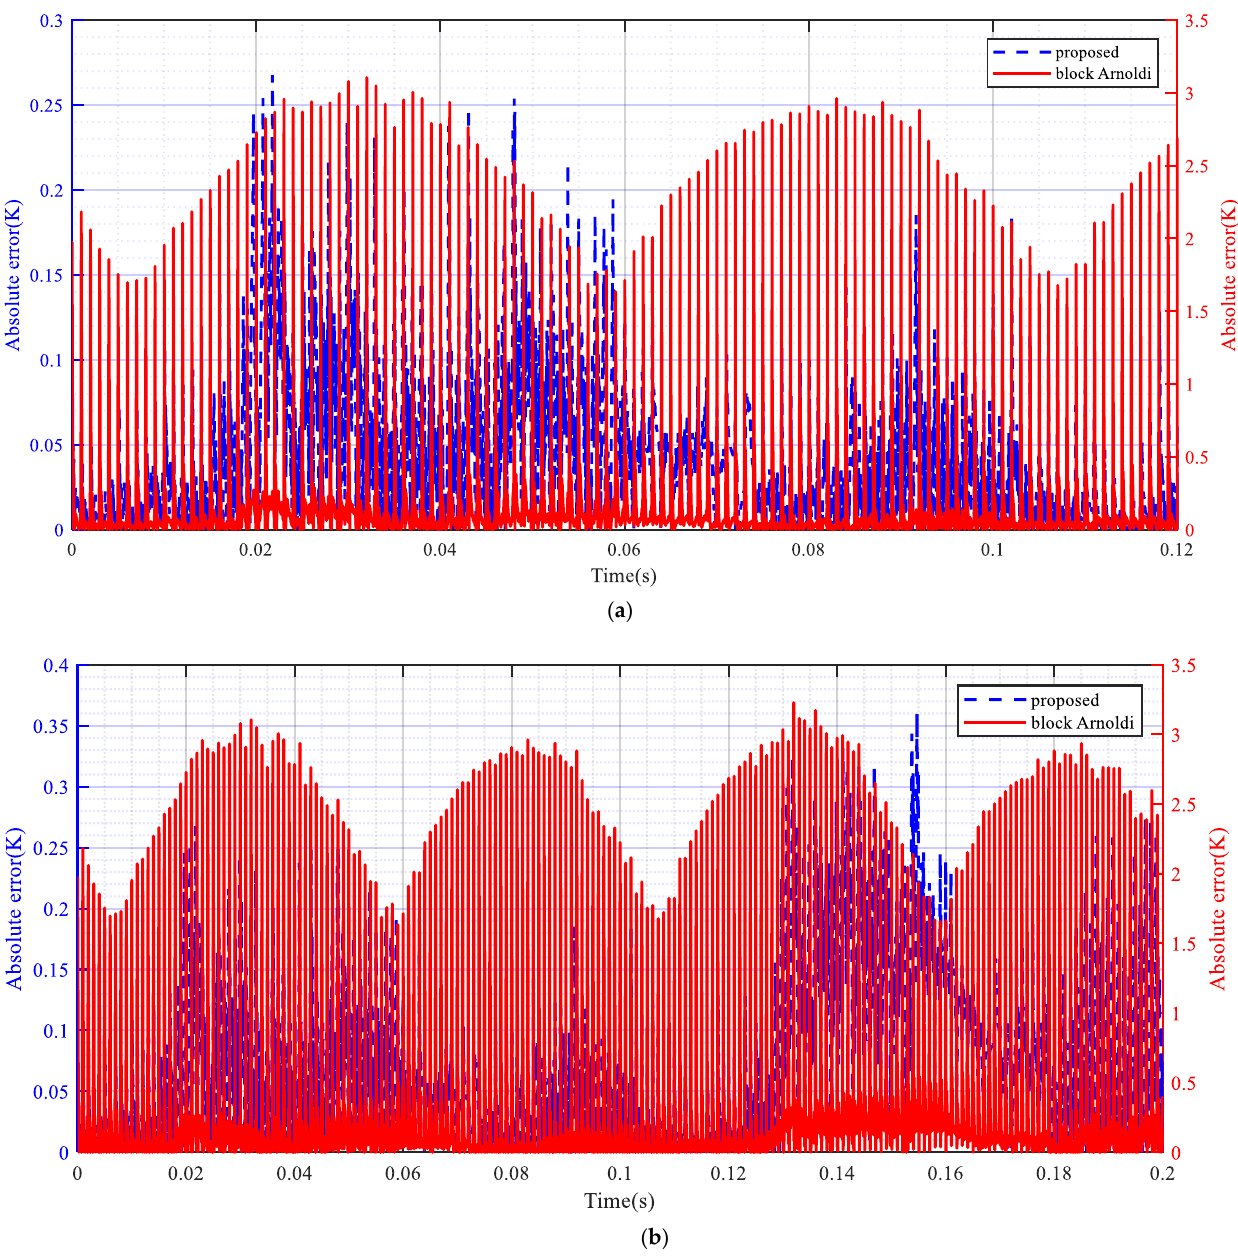
Figure 7. Absolute errors of the computed temperatures observing point 1, using the conventional block Arnoldi algorithm and the proposed scheme, compared to those of the original NTM model under the tested broad-frequency-excitation signal. ( a )Zoom in (0 – 0.12 s). ( b ) Whole excitation duration (0 – 0.2 s).